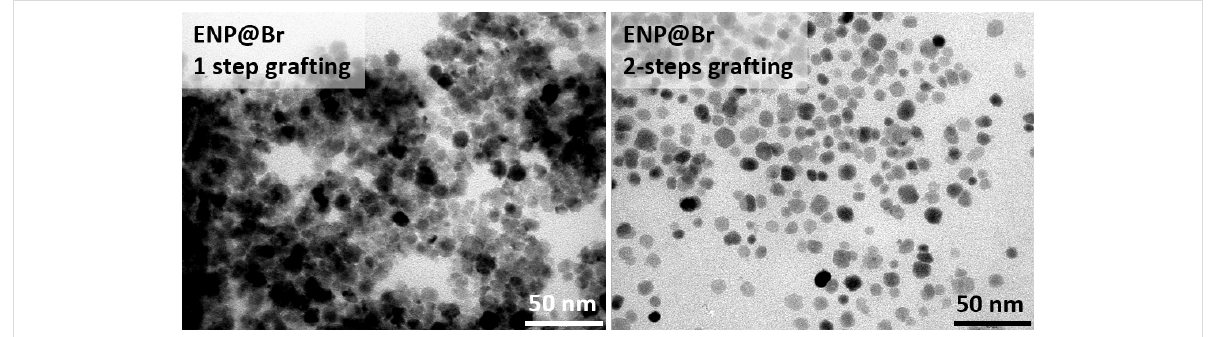
Figure 6: TEM images of a) ENP-Br obtained after centrifugation of as-prepared ENPs and direct grafting of ATRP initiator; b) ENP-Br obtained by two-step ligand exchange by oleic acid followed by grafting of ATRP initiator.